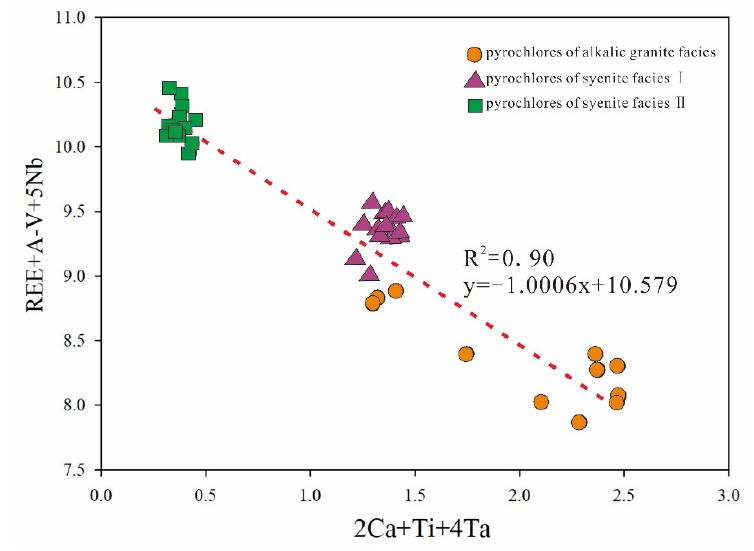
Figure 6. Variation in selected elements (apfu) in pyrochlore supergroup minerals from Boziguoer deposit.